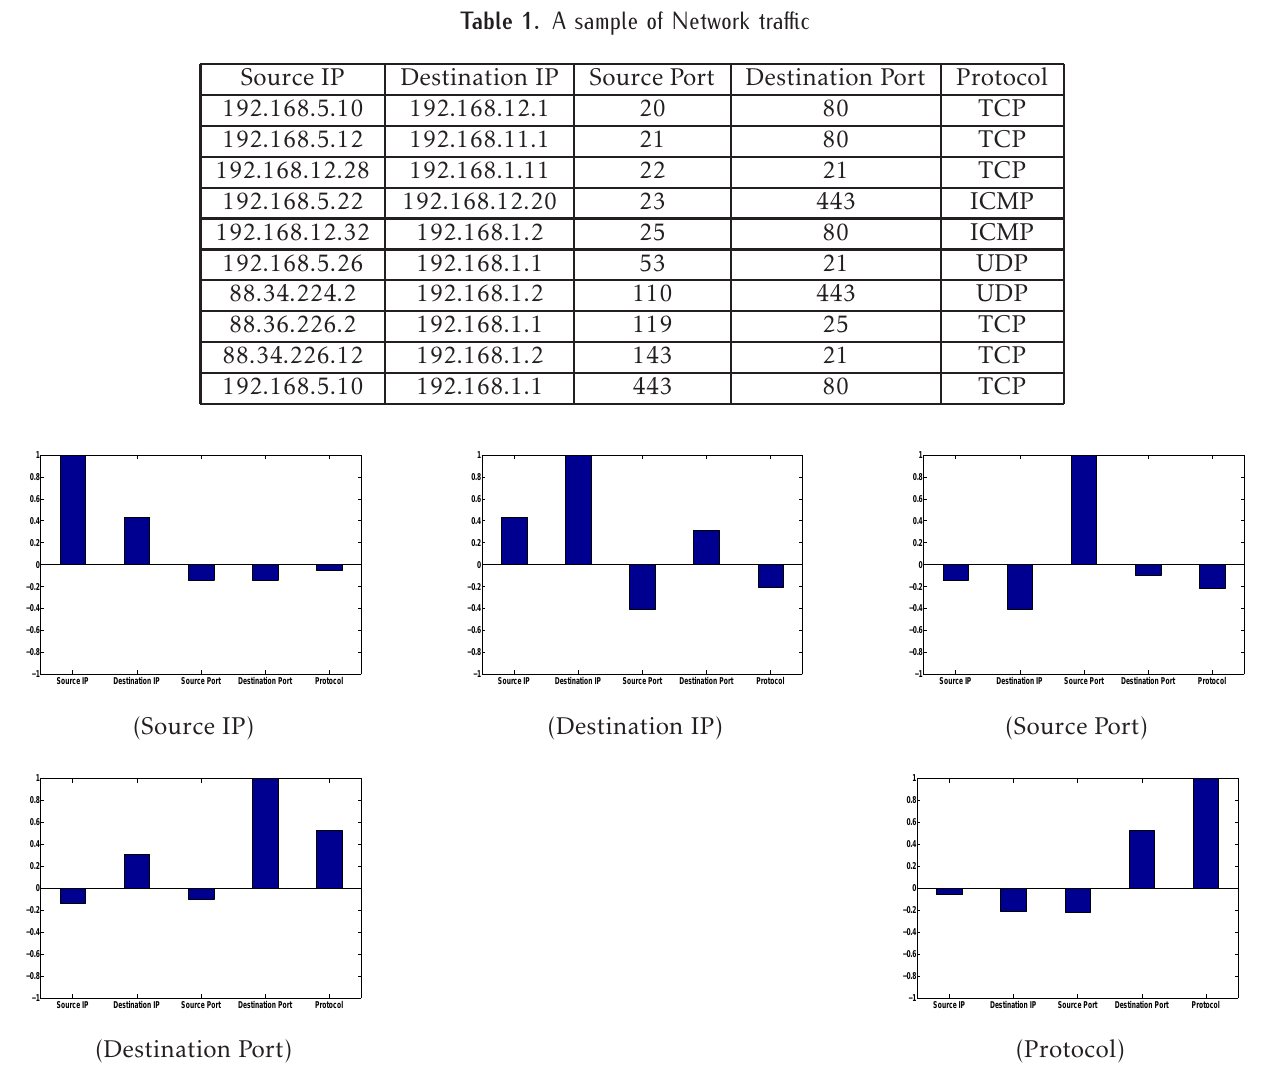
Figure 3. Correlation among the network traffic